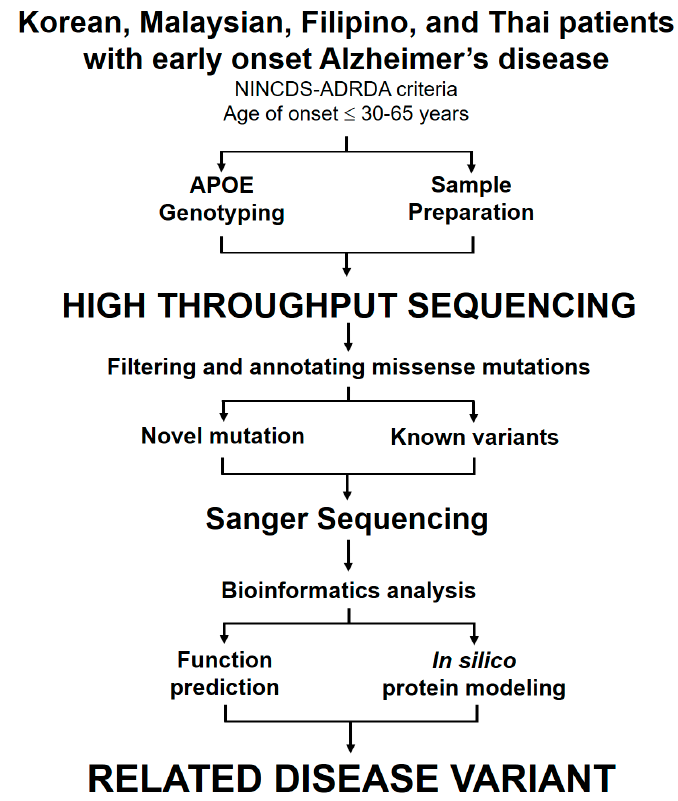
Figure 5. High-throughput sequencing strategy for identifying gene variants in AD patients. The flow chart illustrates the major steps of the working procedure from patient sample analysis to the identification of mutation.